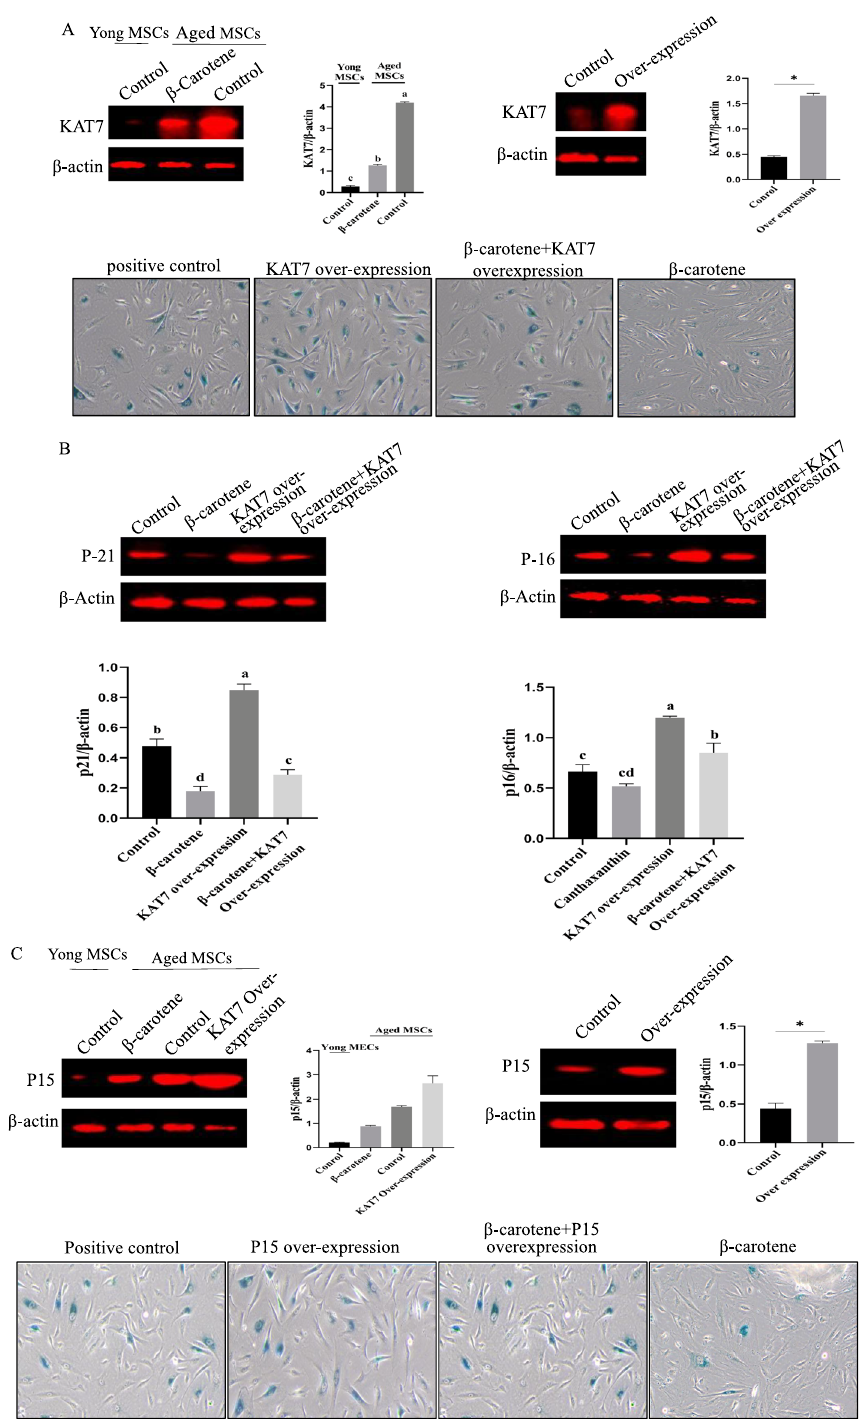
Fig. 9 Analysis of the potential anti-aging mechanism of β-carotene. A The effect of β-carotene on KAT7 expression. n 3 biological replicates. B Effect of KAT7 over-expression on β-carotene anti-aging. C Effect of = p15 over-expression on β-carotene